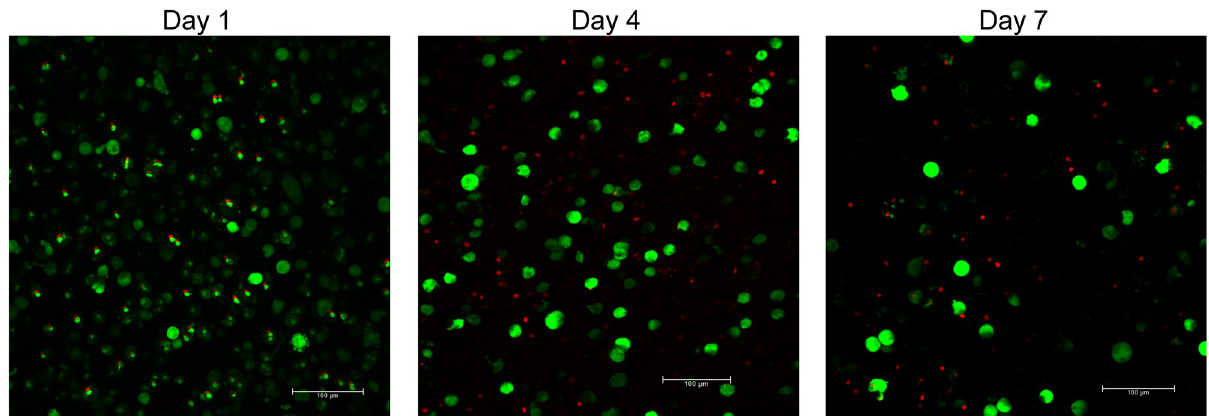
Fig 1. Viability of 3D human hepatic cultures. Imaging of 3D hepatic constructs was performed using a macro-confocal microscope at 20X magnification. Representative LIVE/DEAD images are shown at days 1, 4, and 7. Live cells are marked as green and dead cells are marked by red nuclei. Large clusters/aggregates of viable hepatocytes are observed. All hepatic constructs remained viable for at least seven days of culture. All scale bars are 100 μ m.